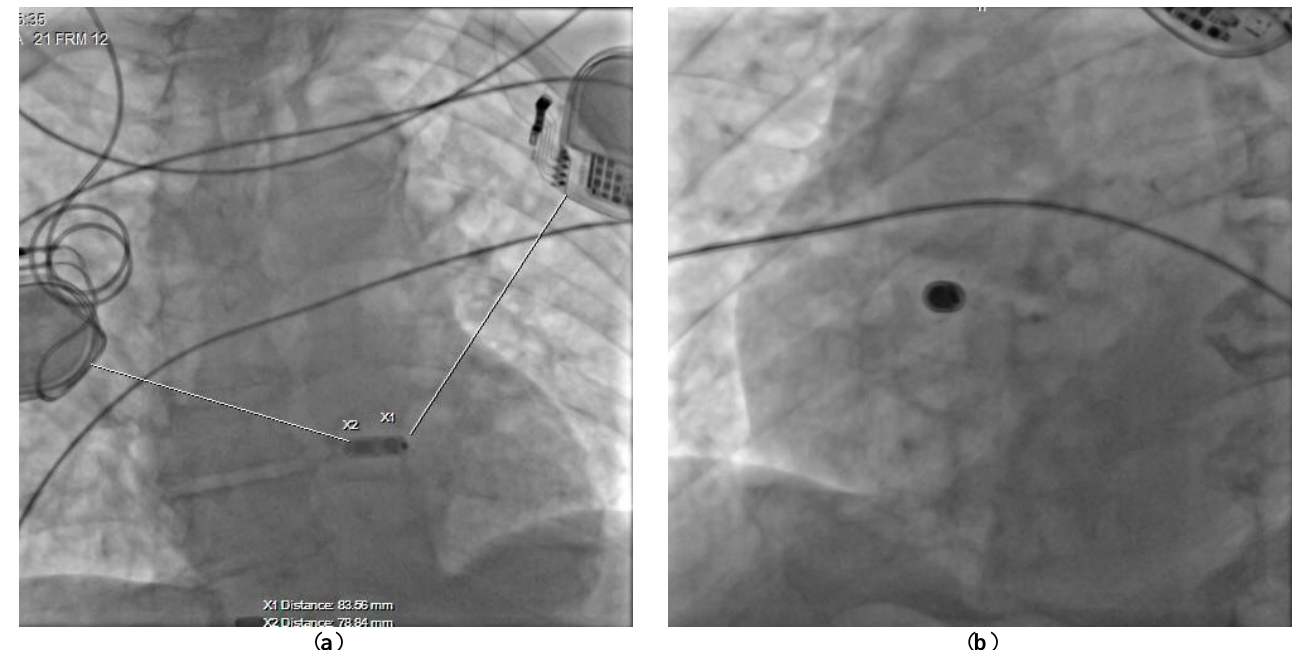
Figure 2. Chest radiogram presenting the final position of the implanted device in ( a ) AP, and ( b ) LAO 32° projections.